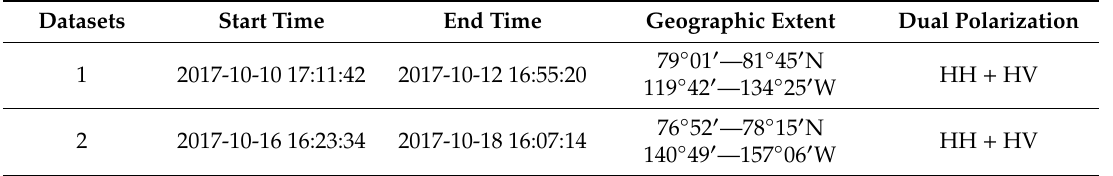
Figure 1. Location of the study area and the Synthetic Aperture Radar (SAR) data for the sea ice drift retrieval. Table 1. List of Sentinel-1 SAR images used in this paper.